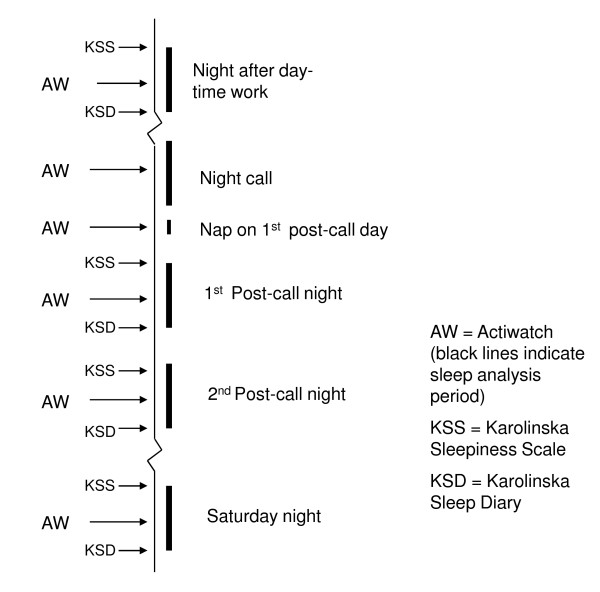
Flowchart for sampling of data.